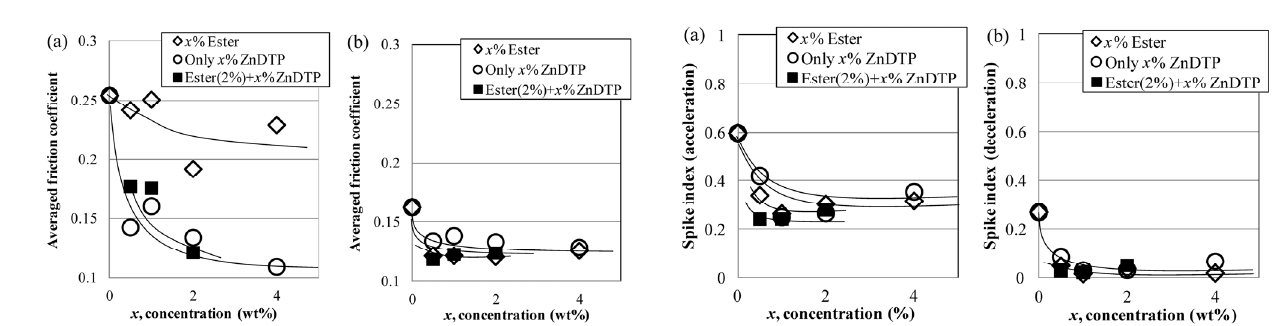
Fig. 10 Correlation between additive concentration and spike index (SI) at 62.8 mm/s: (a) acceleration and (b) deceleration.